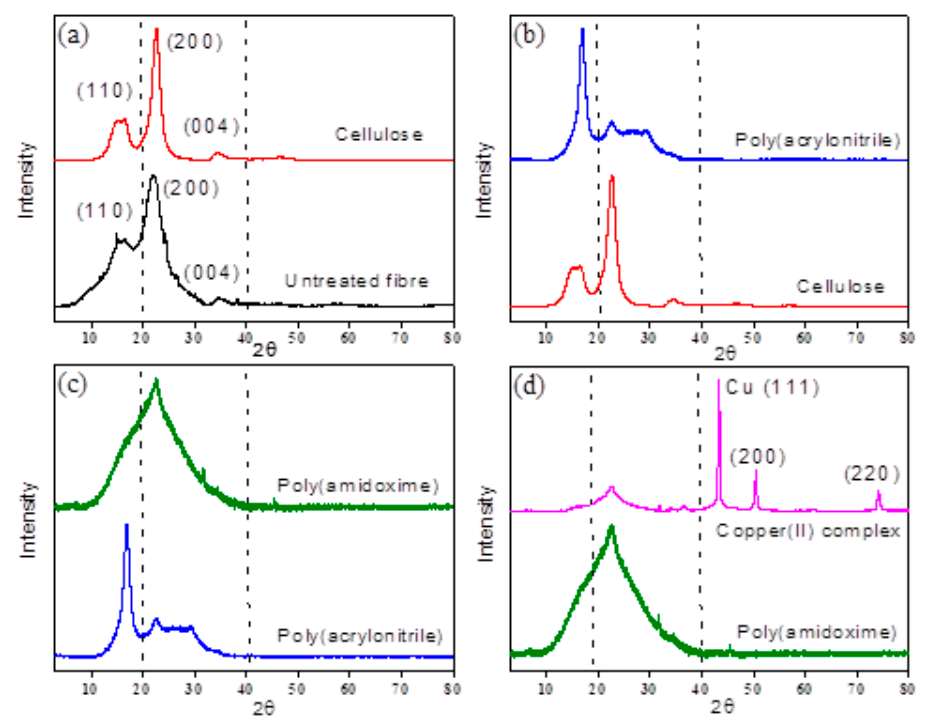
Figure 6. XRD patterns of ( a ) cellulose, ( b ) PAN-grafted cellulose ( c ) poly(amidoxime) ligand and ( d ) PA–Cu complex.